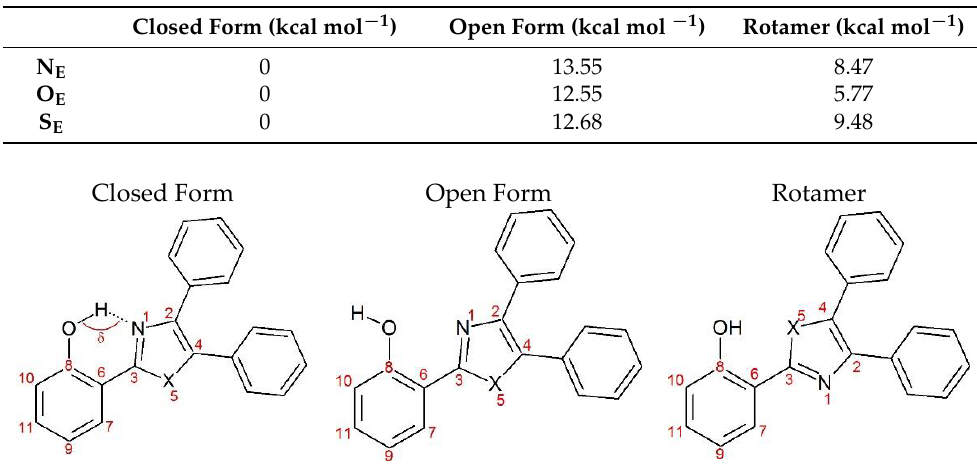
Figure 2. General structure for triphenylimidazole (N E , with X = NH), triphenyloxazole (O E , with X = O) and triphenylthiazole (S E , with X = S), and respective conformers.